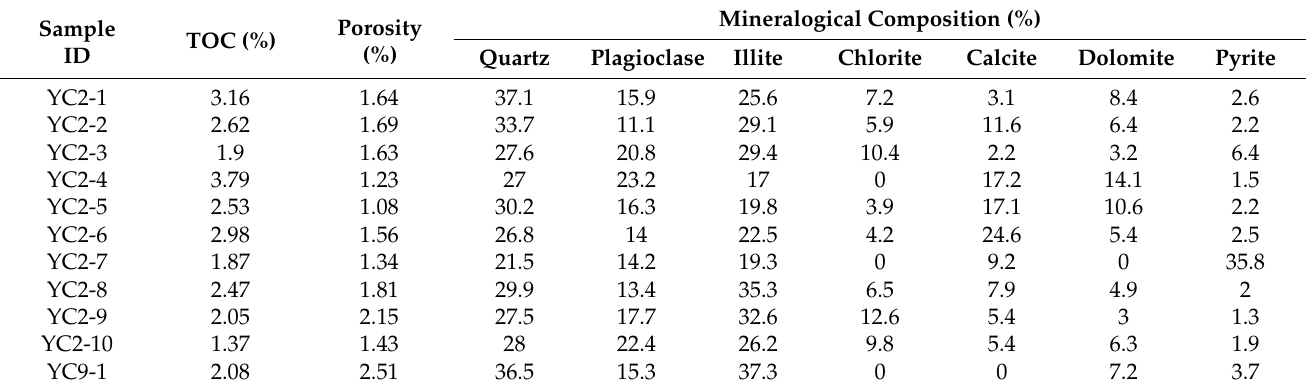
Table 2. TOC content, mineralogical composition, and porosity of shale